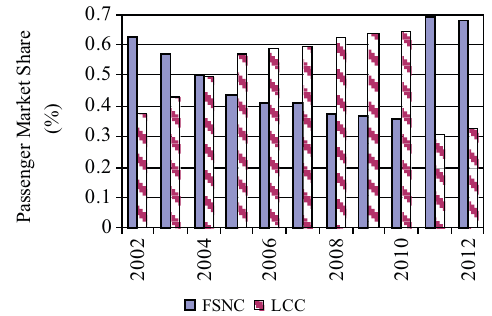
Fig. 3. Full service network and lower cost carrier annual enplaned passenger market share: 2002–2013 (Bureau… 2014; Qantas Airways 2009, 2013; Tiger Airways (various); Virgin Australia